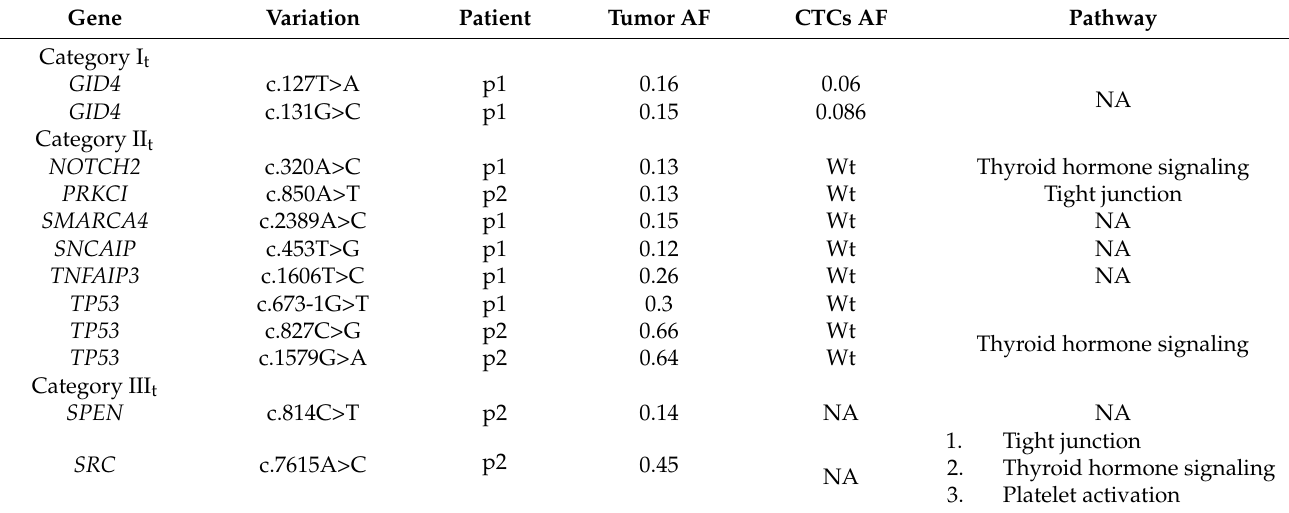
Table 2. Somatic mutations detected in tumors of the two EOC